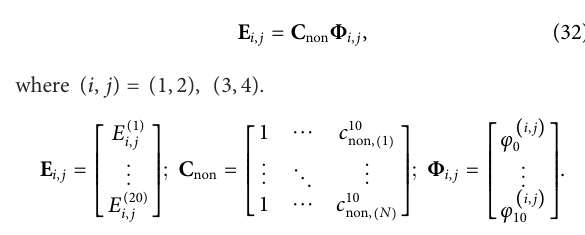
( i,j ) ( j ω ) , λ ( i,j ) ( j ω ) , / , λ ( i,j ) where λ 0 1